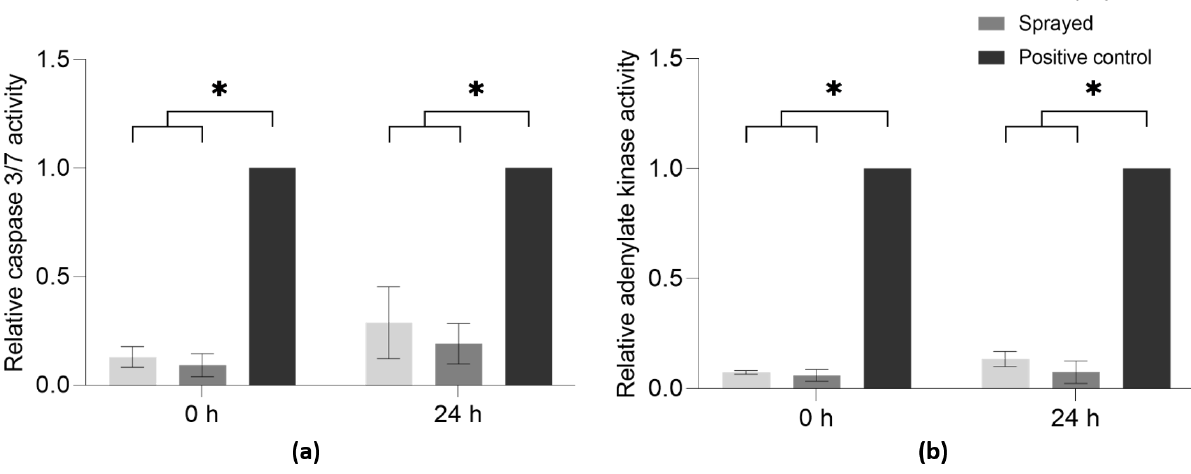
Figure 5. Apoptosis and necrosis of HUVECs ( n = 3) after aerosolization. Non-sprayed cells served as a control. ( a ): Apoptosis was analyzed directly after and 24 h after spraying by caspase 3/7 activity and normalized to a staurosporine-incubated control; ( b ): Necrosis was evaluated directly after and as 24 h after spraying by adenylate kinase activity and normalized to a 100%-lysis control. Significant differences ( p < 0.05) are marked with *.